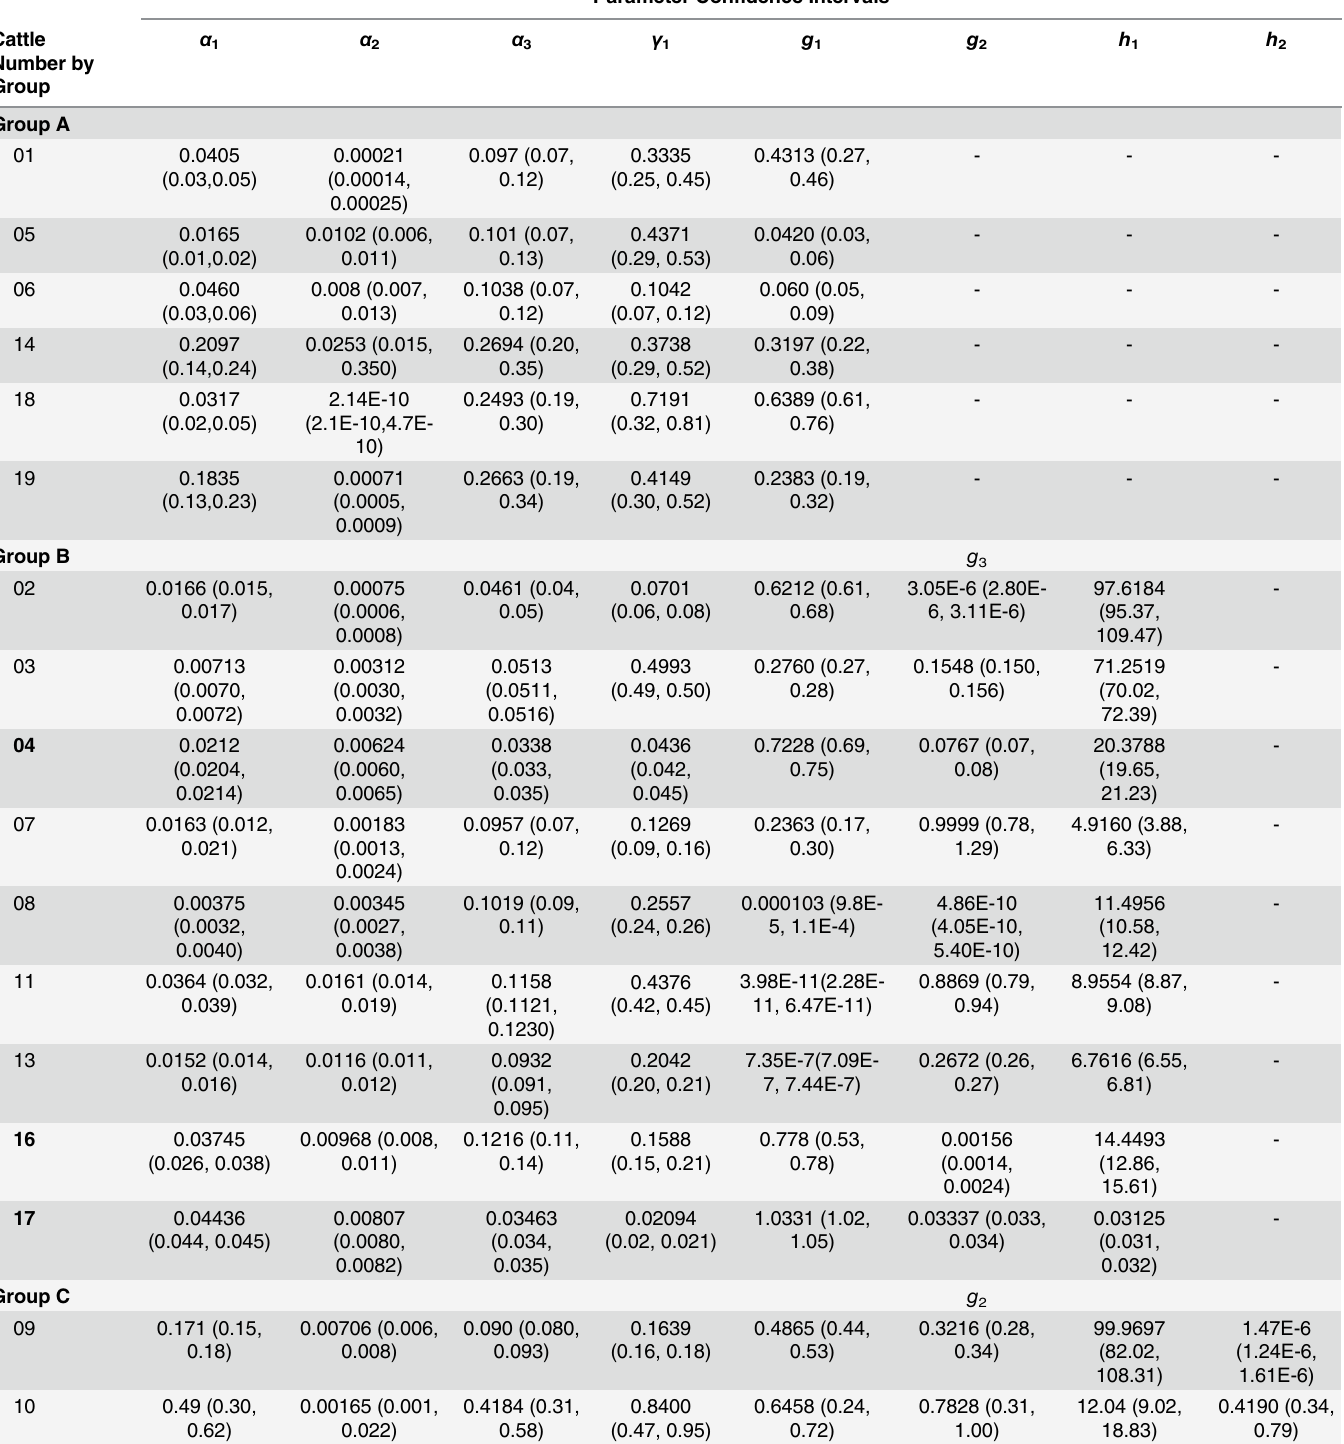
Table 1. Estimated Parameters. A dash (-) indicates a parameter was excluded (not relevant to explain data for that animal) from the fitting procedure, and therefore the corresponding biological process was not essential in explaining the data. Parameters β 1 and β 1 were fixed at 0.01 during fitting using all models with data from all